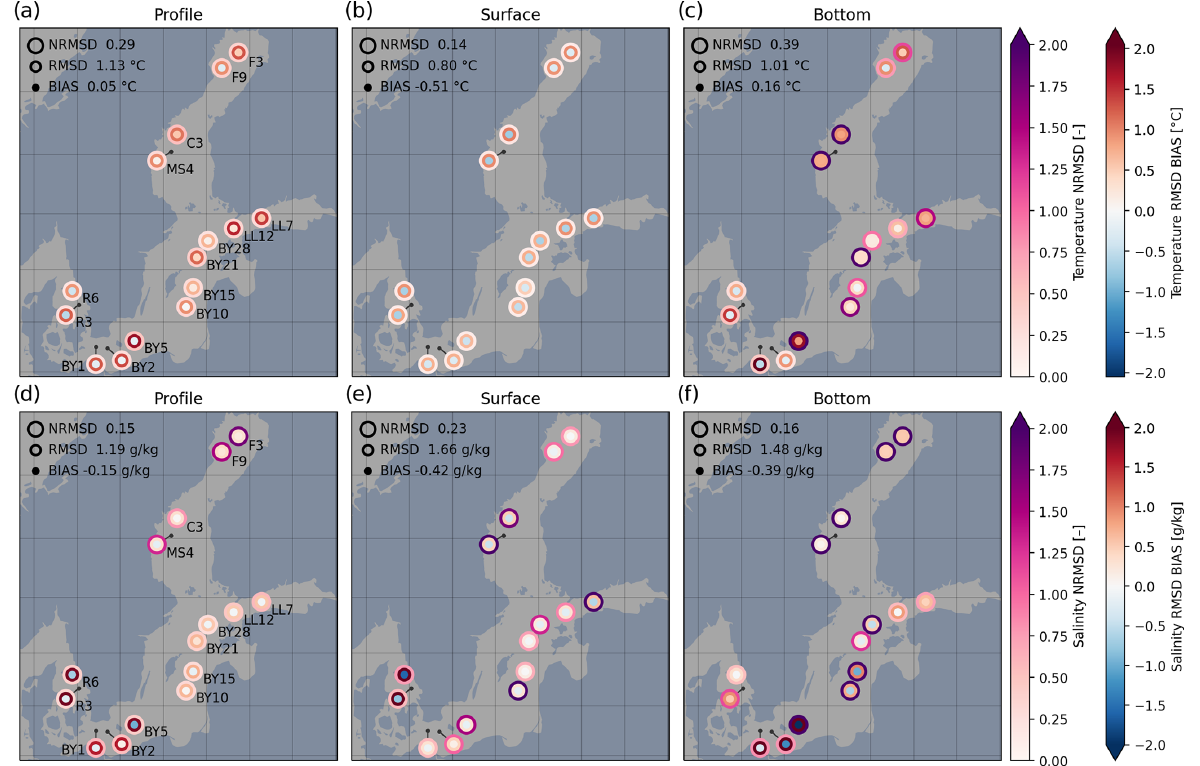
Figure 8. Vertical profile comparison against vessel observations; temperature (a–c) and salinity (d–f) . The dots depict NRMSD (outer ring), RMSD (inner ring), and bias (center dot). The metrics have been calculated for the entire profile (a, d) , surface 10m (b, e) , and bottom (c, f) . Combined metrics over all the stations are printed in each panel. Bottom values were computed for the lowest 15% of the water